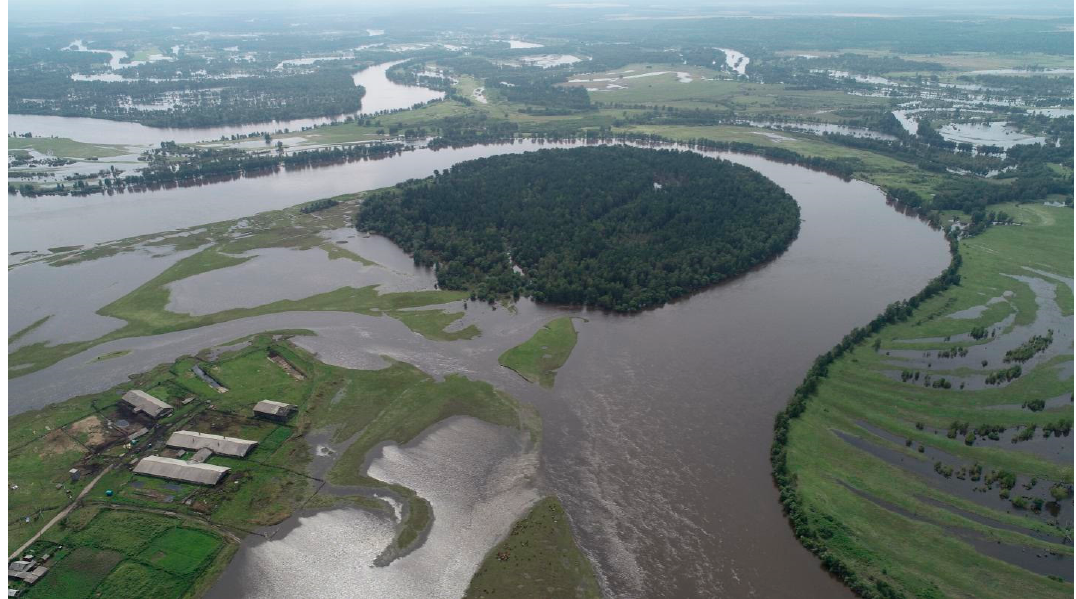
Figure 18. The flooded negative forms of the floodplain topography of the broad floodplain section ◦ 24 (cid:48) 27.4291” N, 100 ◦ 43 (cid:48) 23.1787” E. The image was of the Iya river (the village of Gadalei). Coordinates: 54°24 ′ 27.4291 ″ N, 100°43 ′ 23.1787 ″ E. The image the Iya river (the village of Gadalei). Coordinates: 54 taken on 2 August 2019 (second wave of the flood in